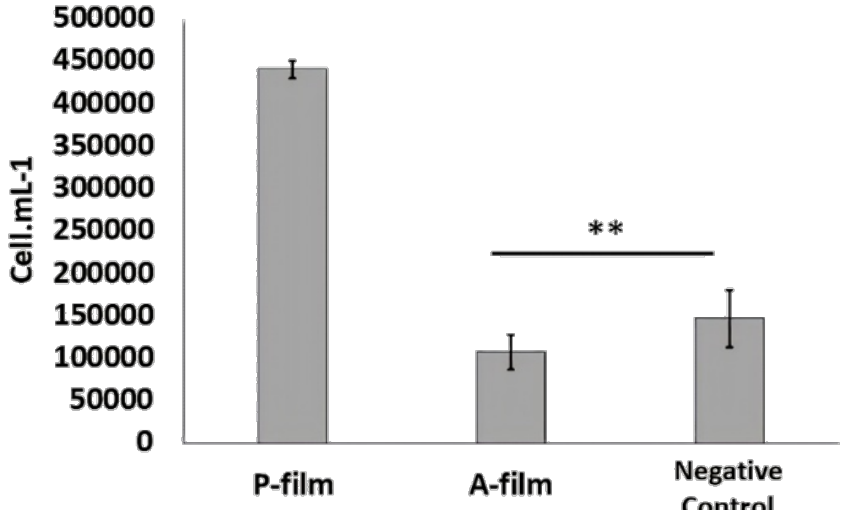
Figure 9. Results of the cell viability study in the presence of P-film and A-film after 24 h (**) no statistical di ff erence ( p > 0.05). MCF-7 cells were plated (3 × 10 4 cells / mL − 1 ) in a 6-well culture plate and incubated for 24 h. A-film and P-film were placed in duplicated into 4.5 mL of culture medium (Nutricell ® ) and they were incubated for 24 h. The cell growth was measured by counting technique in the Neubauer chamber. The number of cells was recorded and compared with control.